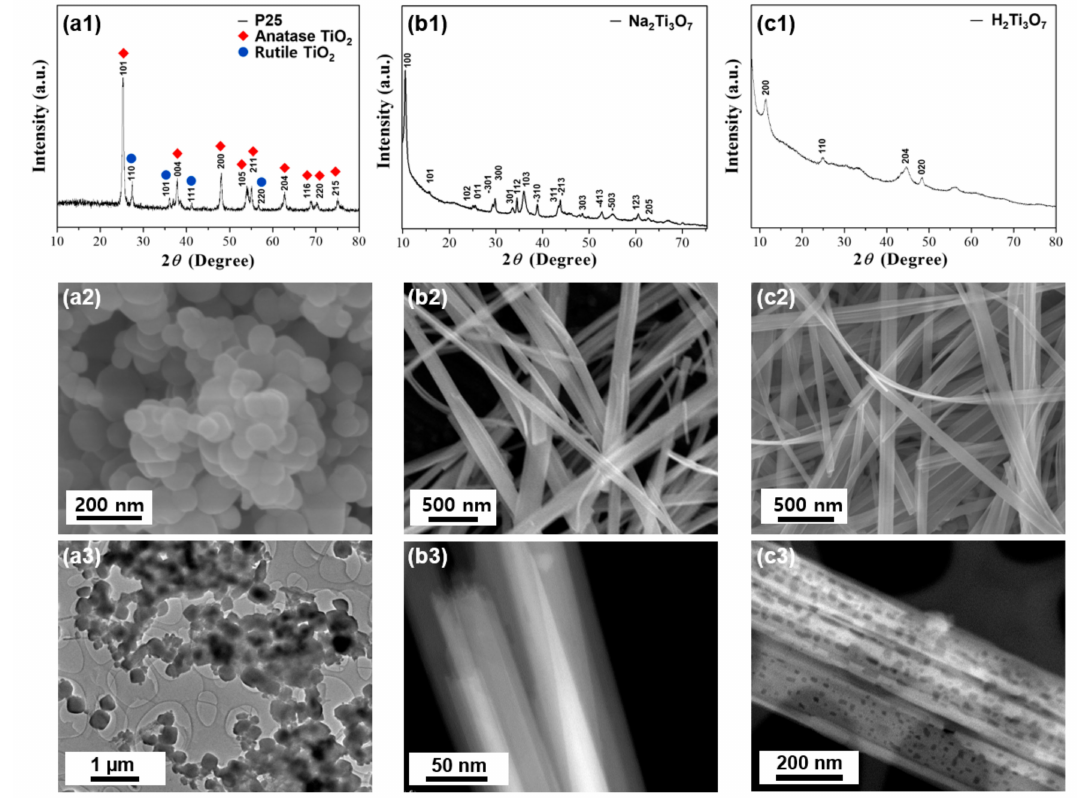
Figure 1. X-ray di ff ractometer (XRD) patterns, SEM images, and transmission electron microscopy (TEM) images of ( a1-3 ) the starting P25 powders, ( b1-3 ) Na 2 Ti 3 O 7 nanobelts, and ( c1-3 ) H 2 Ti 3 O 7 nanobelts, respectively.